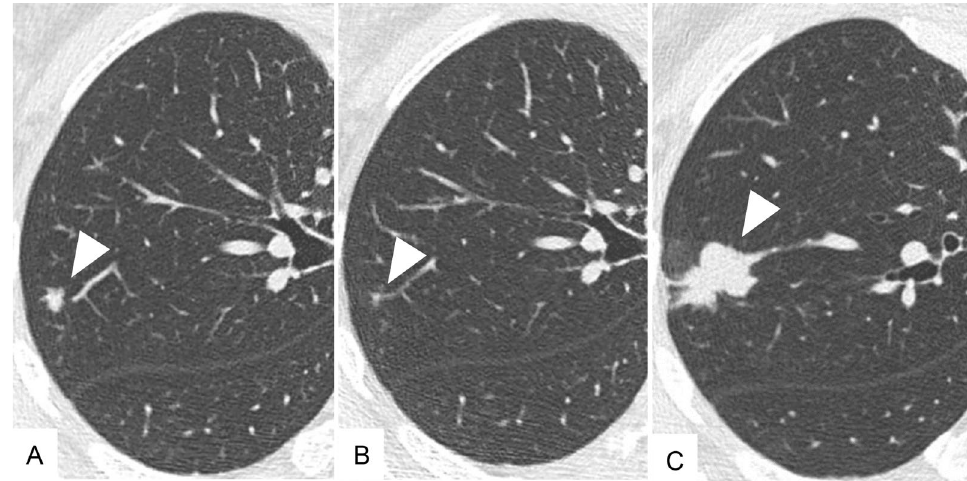
Fig. 2 A A chest CT 7 years after radical surgery for the leiomyosarcoma showed a 4-mm irregular nodule (arrow). B The nodule regressed spontaneously to 2 mm after an additional 6 months. C The nodule regrew up to 24 mm over the next 5